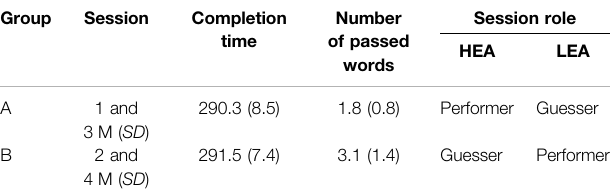
TABLE 3 | Summary of objective measurement results.